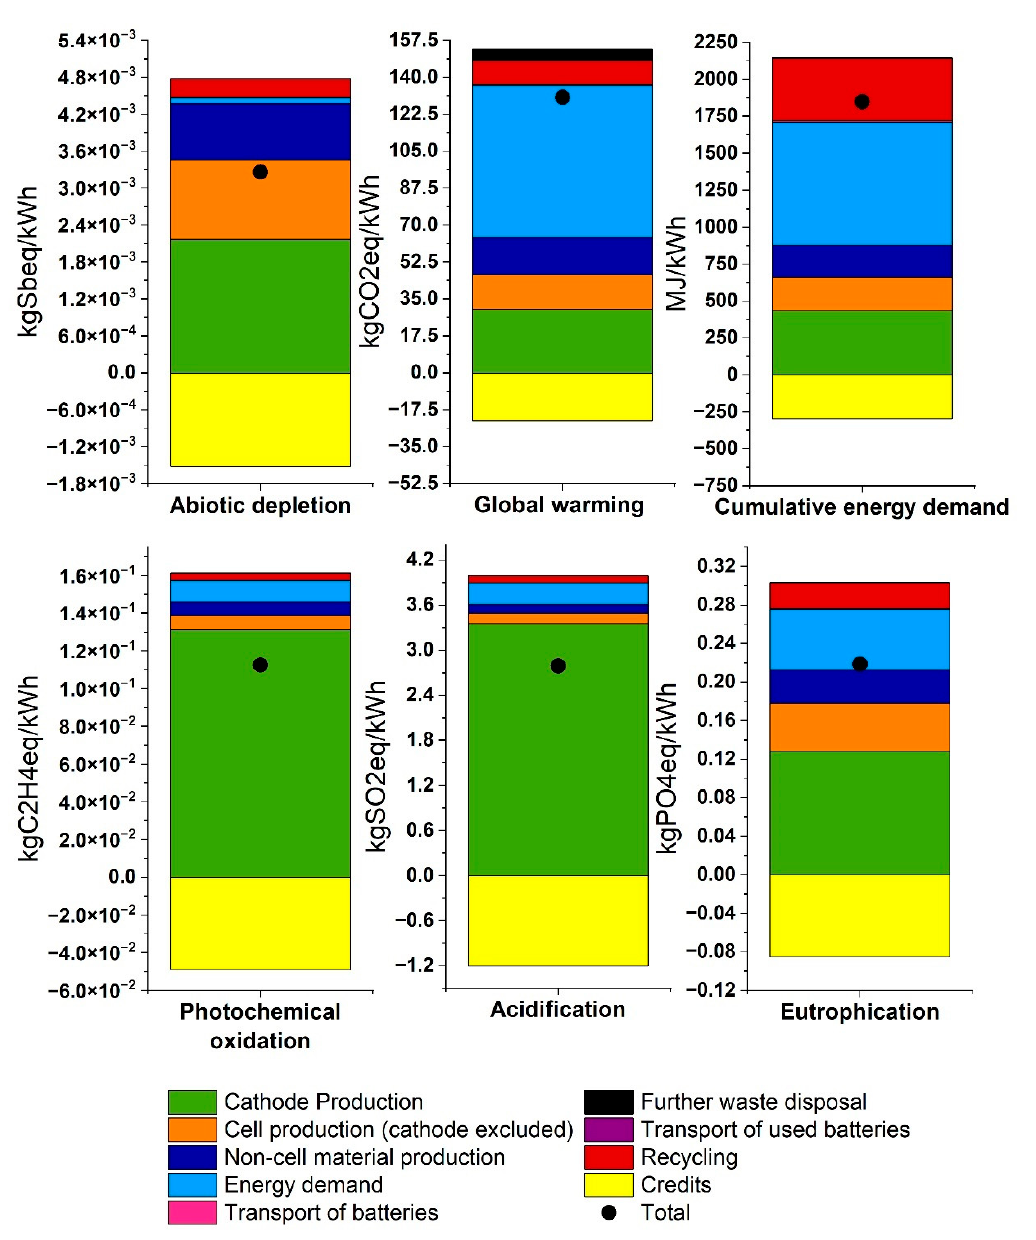
Figure 3. Impacts of NMC111 production and EoL per 1 kWh of battery pack (N.B.: the contribution of the battery use phase is not reported in this plot).